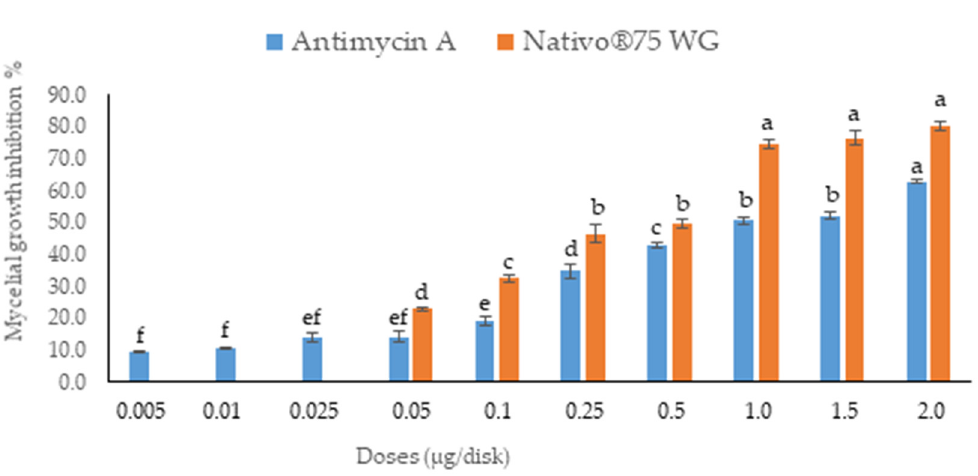
Figure 2. Macroscopic and microscopic view of in vitro antifungal activity of antimycin A and the commercial fungicide Nativo ® 75 WG against M. oryzae Triticum (MoT) at 20 µg/disk. The macroscopic images are ( a ) control, ( b ) antimycin A, and ( c ) Nativo ® 75 WG, whereas, ( a(i) ), ( b(i) ), and ( c(i) ) are microscope images of control, antimycin A, and Nativo ® 75 WG, respectively. Bar = 50 µm.